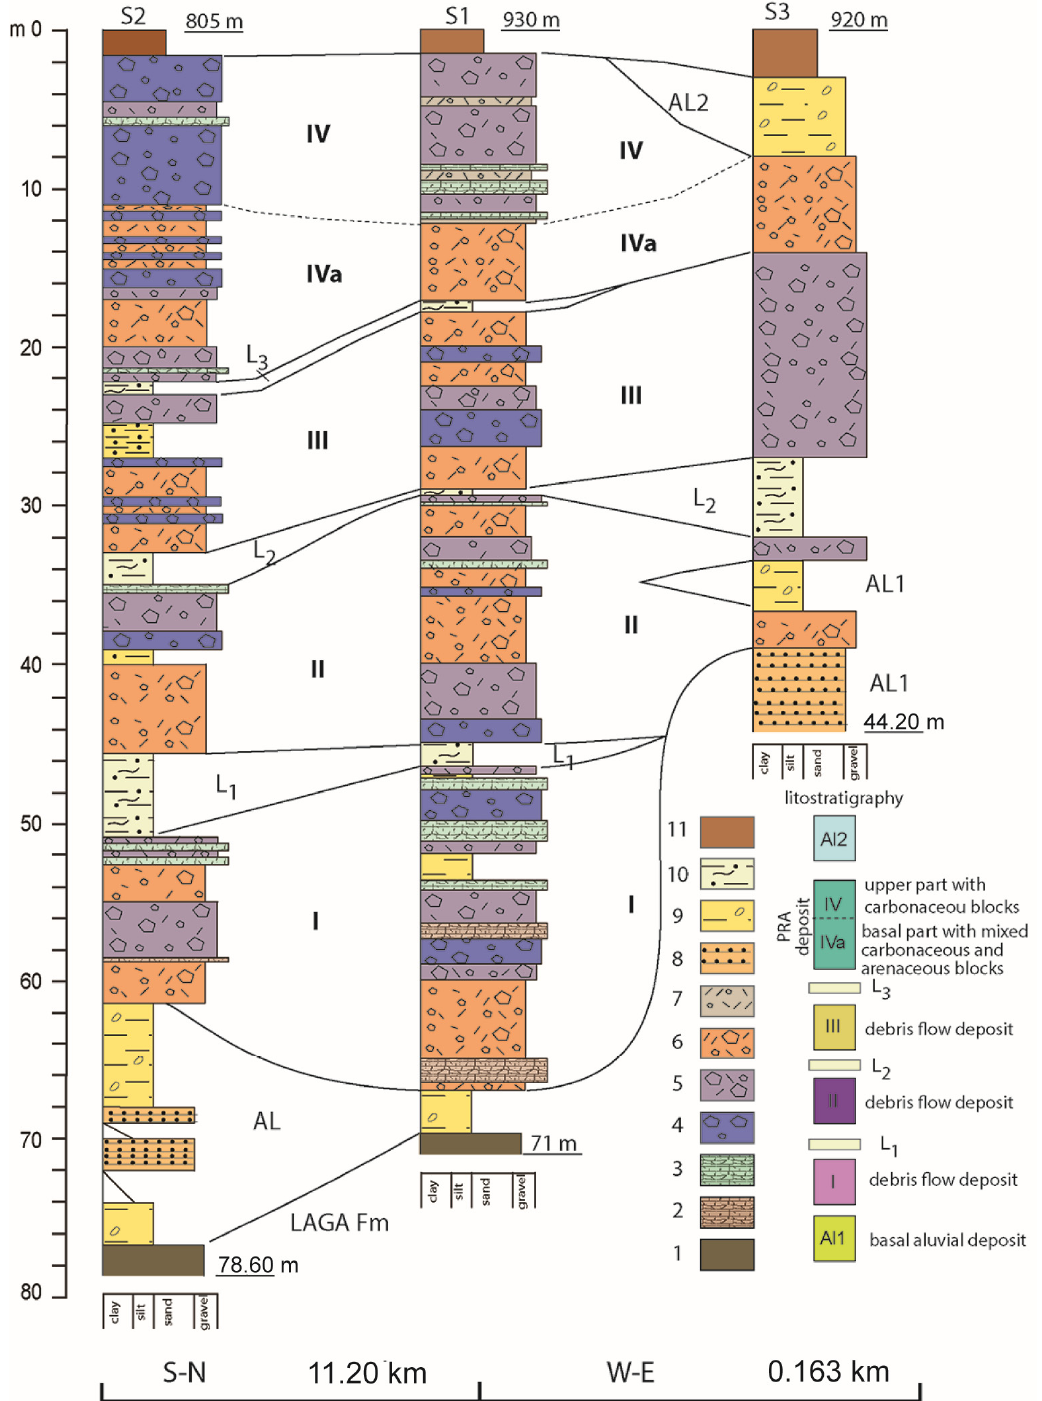
Figure 6. Boreholes realized in the floodplain of the Morricone Stream [63]. Legend: (1) Laga Formation, (2) arenaceous megablocks, (3) carbonate megablocks, (4) heterometric calacareous debris with carbonate megablocks, (5) heterometric calcareous debris in a poor gravel matrix with megablocks, (6) heteometric debris in a sandy-gravel matrix with arenaceous and carbonate blocks, (7) debris in an abundant sandy-silt matrix with calcareios clasts and pebbles, (8) coarse sands, (9) clay silts with limestone and sandstone pebbles, (10) weathered sandy and clay silts, (11) soil. The sequence IV is made up only by carbonate clast and boulders, with poor or absent matrix. At the base of this sequence, arenaceous clasts and boulder levels are found.